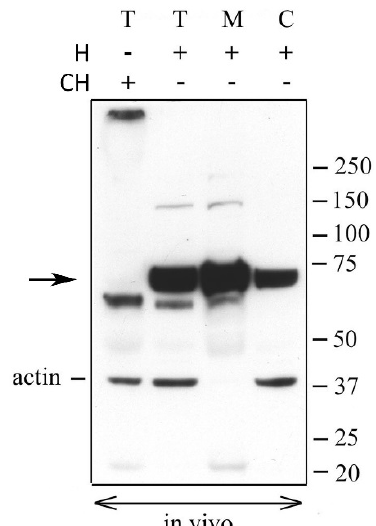
Figure 1. Versican fragments containing the neo-epitope DPEAAE are detected in OCCs expanded in vivo. The complexes expanded in vivo were isolated from naturally cycling gilts (two porcine OCCs for each lane). Total (T), matrix (M) and cell (C) extracts from expanded OCCs digested with Streptomyces hyaluronidase (H) or chondroitinase ABC (CH) were analyzed by western blot with anti-DPEAAE versican antibody. Actin immunodetection was performed to compare sample loading. A representative blot of four independent experiments is shown.